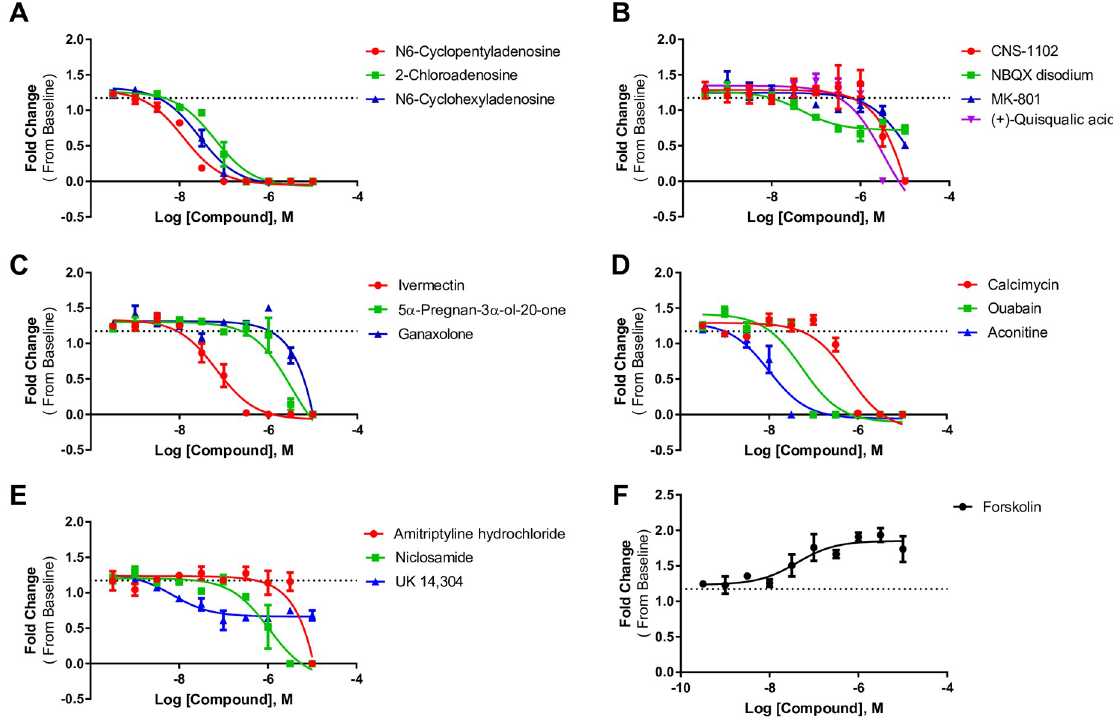
Fig 5. Concentration response curves of peak frequency. A) Adenosine receptor agonists, B) glutamate receptor compounds, C) GABA receptor compounds, D) blockers of various channels, E) other compounds, and F) concentration response of forskolin. Each point represents n = 3 wells. The dashed line on each graph represents the average of the DMSO-treated wells.